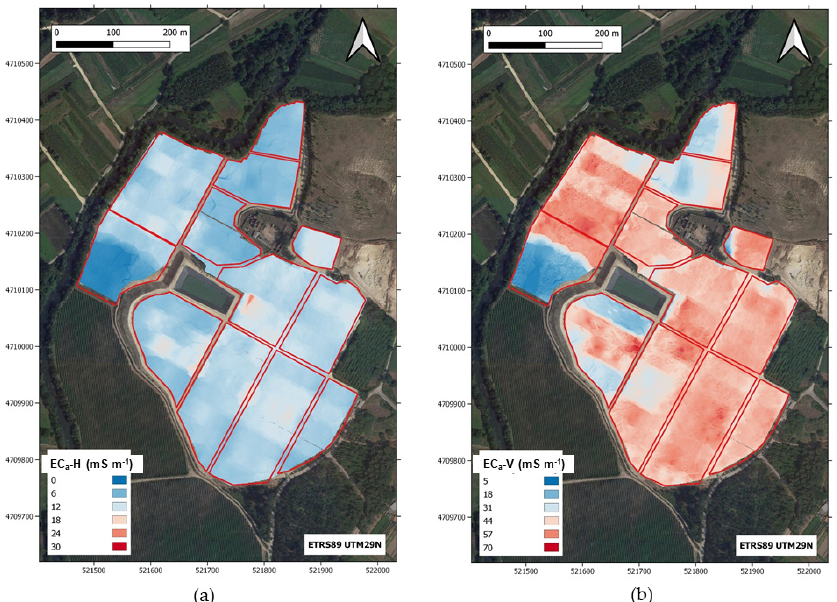
Figure 3. Soil apparent electrical conductivity (EC a ) maps of the experimental vineyard obtained with the horizontal ( a ) and vertical ( b ) dipoles of the EM-38 equipment and interpolated through regression kriging on 29 May